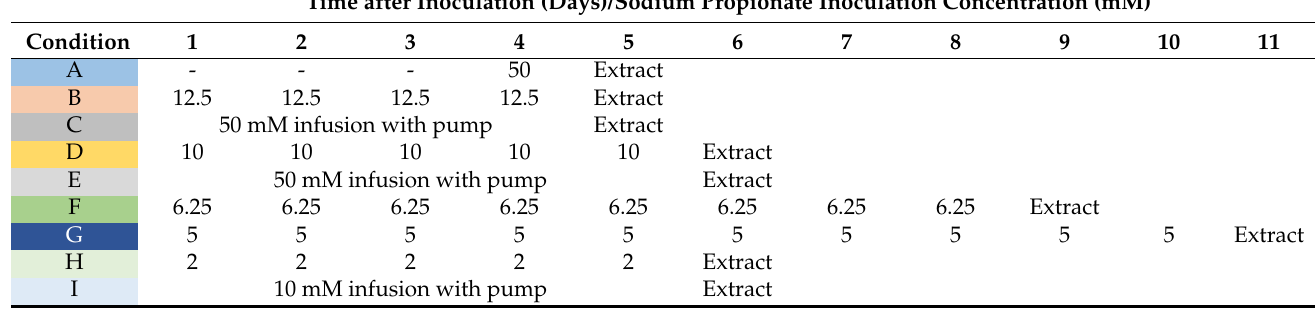
Table 1. Description of sodium propionate feeding